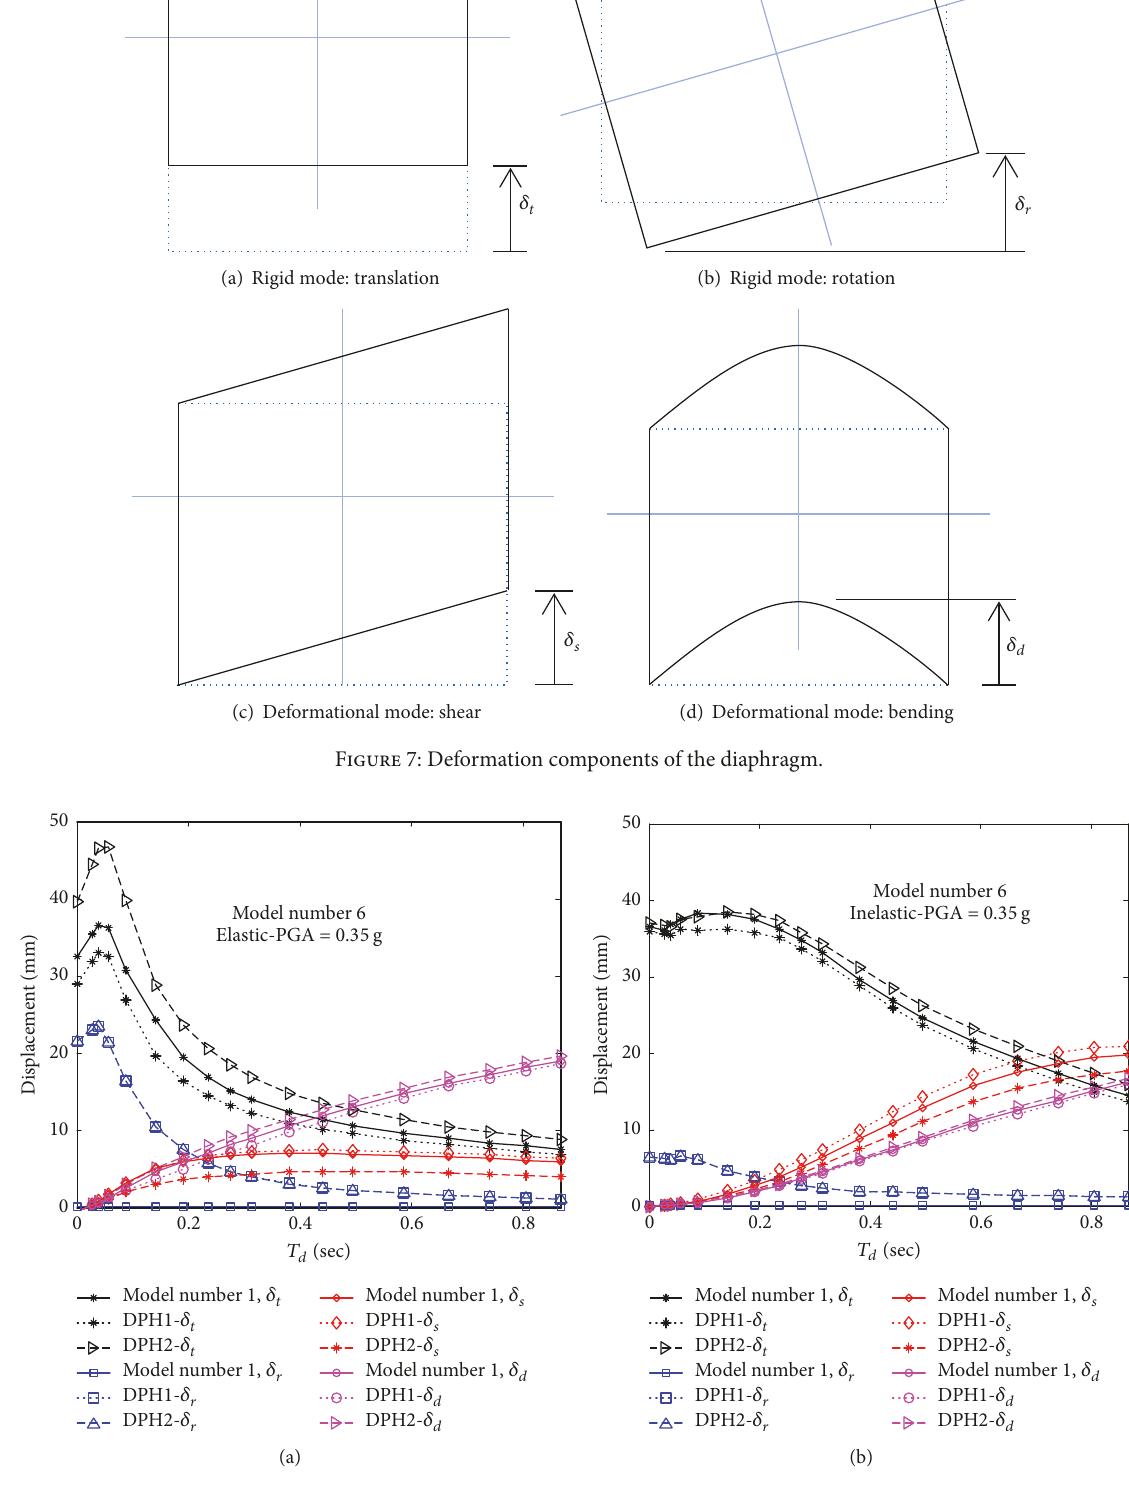
Figure 8: Deformation components of diaphragms for model 6 in DBE earthquakes: (a) elastic and (b)